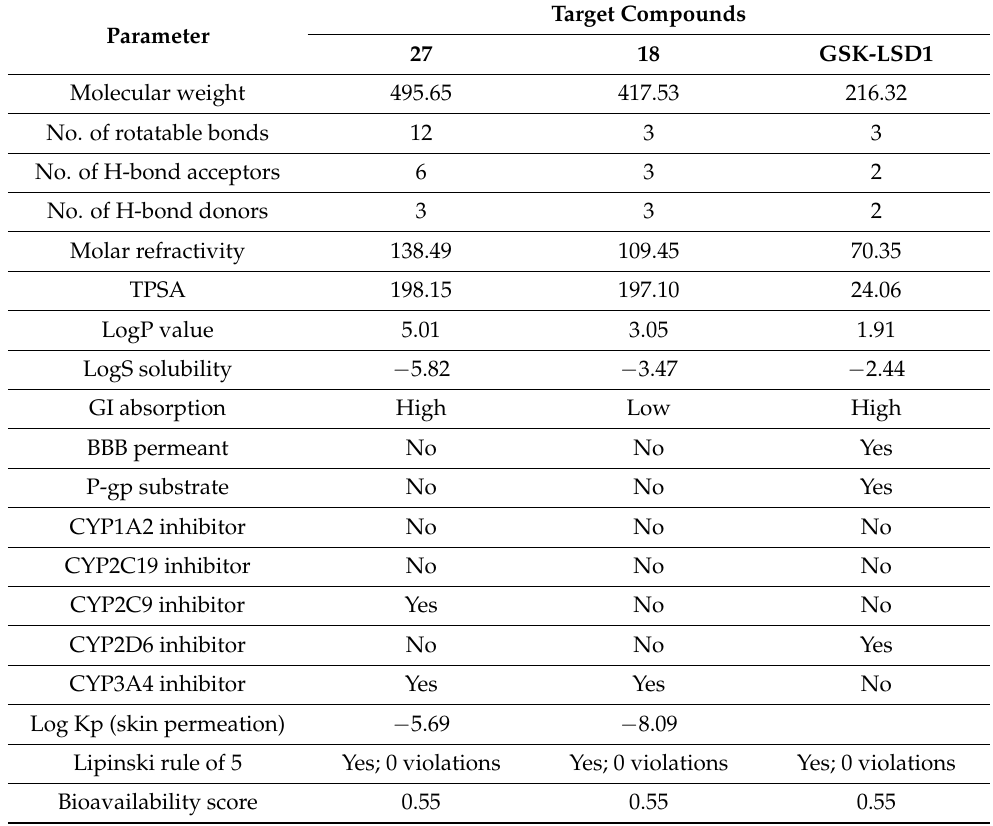
Table 7. Physicochemical descriptors and ADME